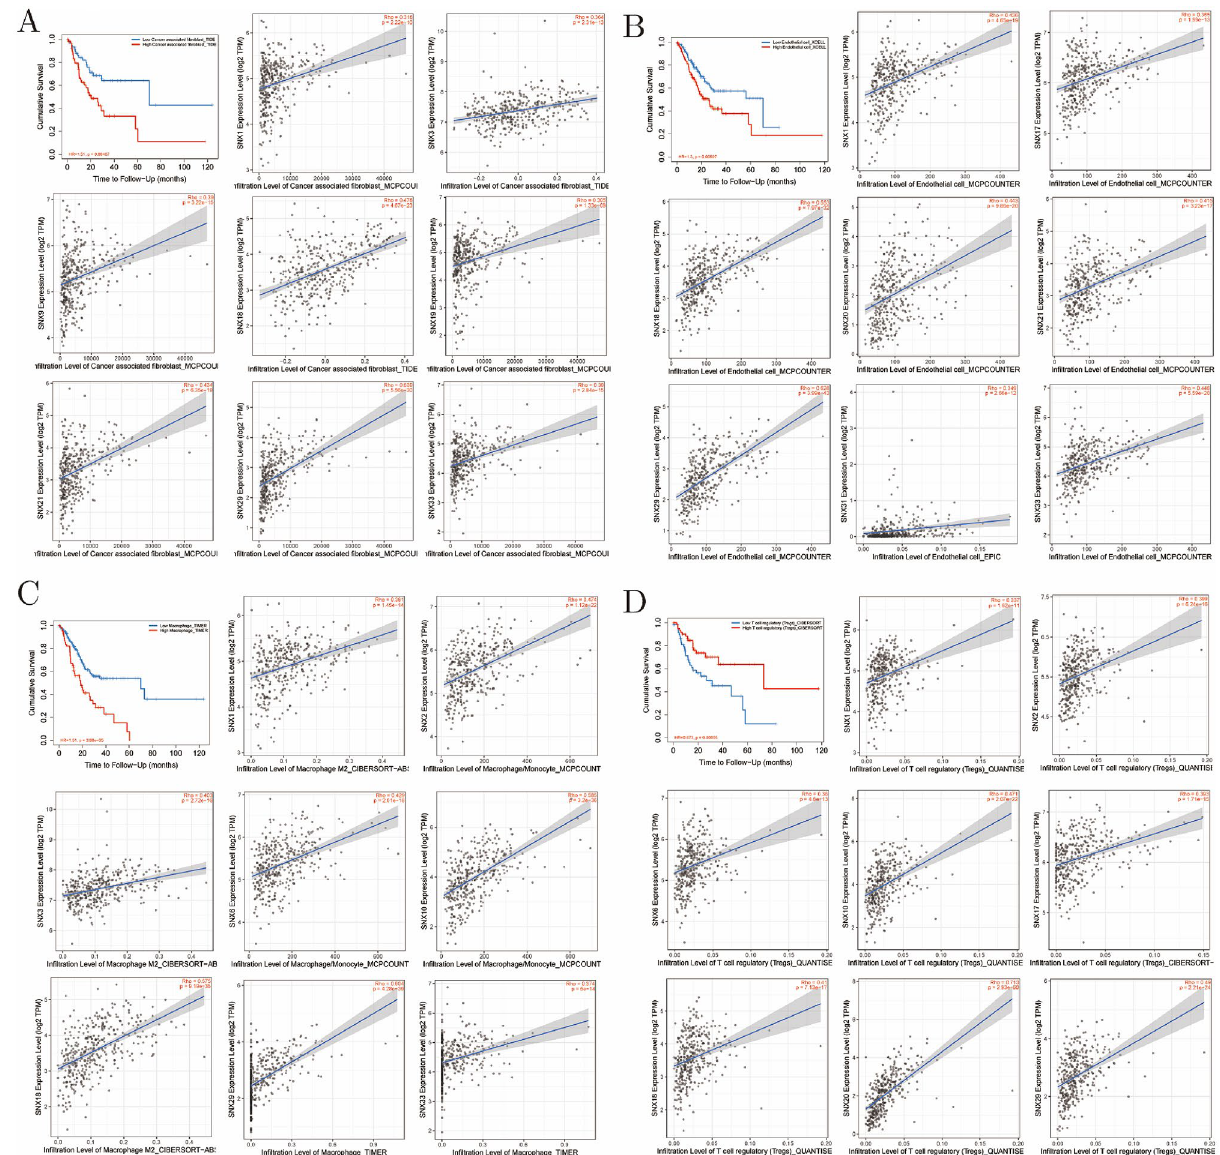
Figure 4. Tumor immune infiltration analysis using cBioportal. Cumulative survival associated tumor infiltrating immune cells (TIICs), cancer associated fibroblast ( A ), endothelial cells ( B ), macrophages ( C ), Tregs ( D ), and top 8 SNXs related to the four TIICs with Spearman coefficients over